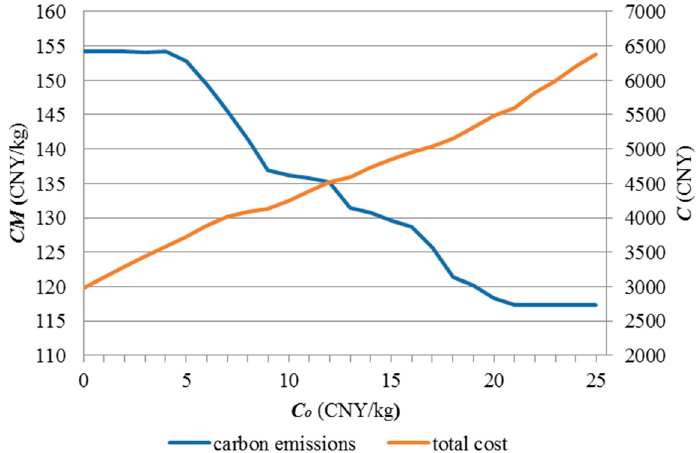
Figure 4. The line chart that shows the changing trends of total cost and carbon emissions as the carbon tax changes.